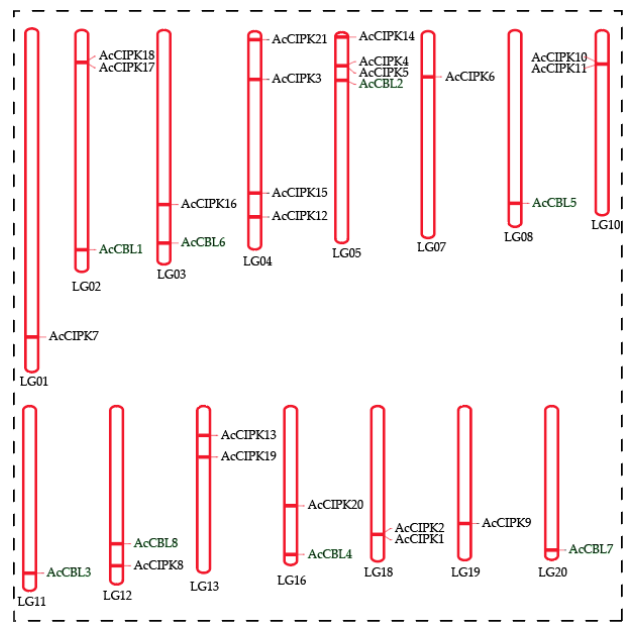
Figure 4. Chromosomal locations of pineapple CBL and CIPK genes. The 8 CBL and 21CIPK genes of pineapple were mapped to different chromosomes using MapChart.